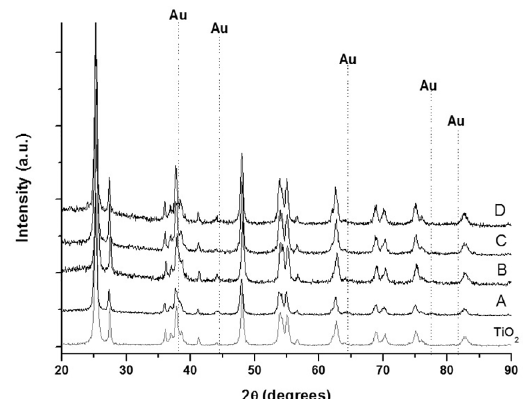
support and Au/TiO 2